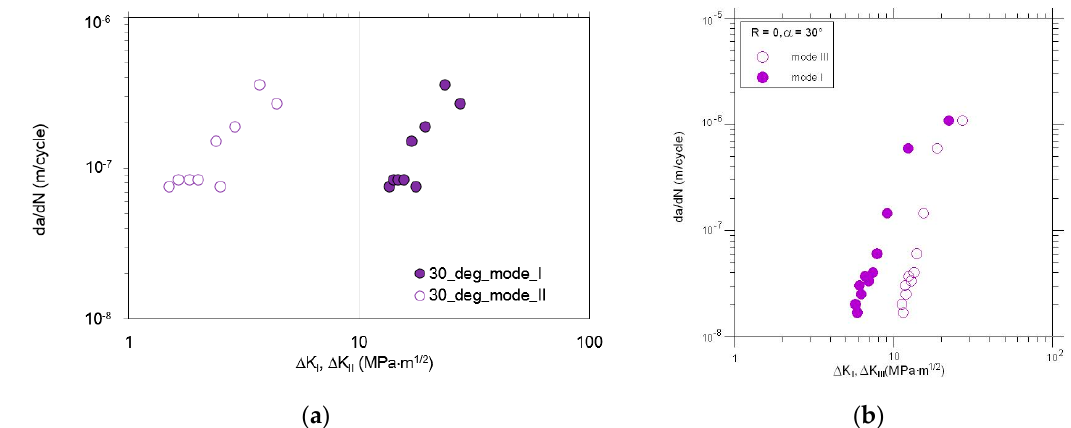
Figure 10. Comparison of the fatigue crack growth rates vs. ∆ K vs. for α = θ = 30 ◦ : ( a ) Mode I and II; ( b ) mode I and III.